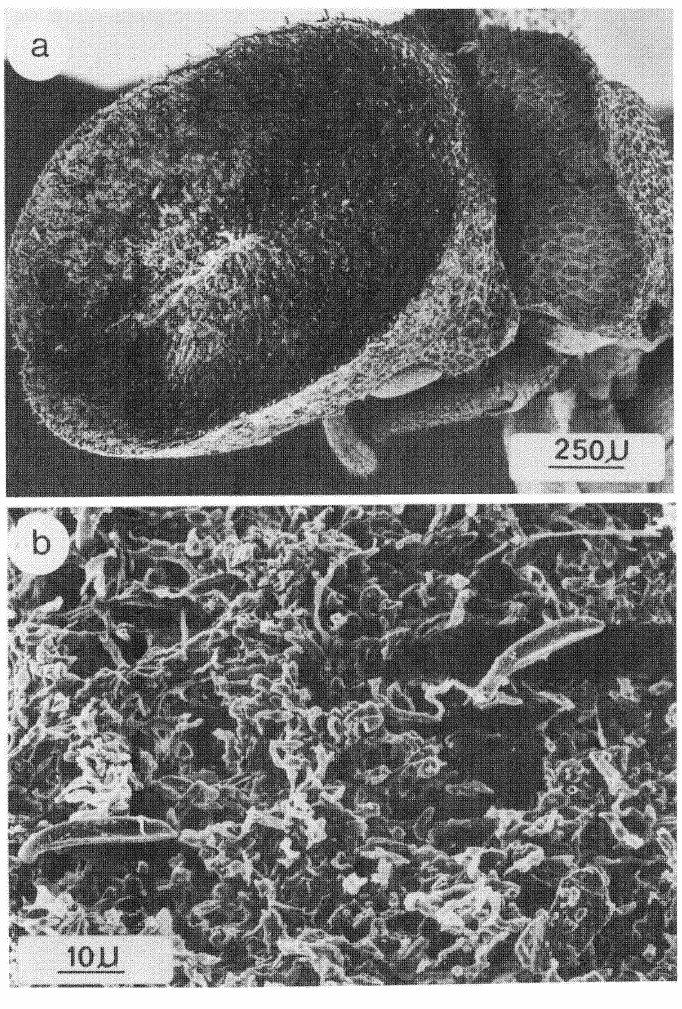
Fig. 4. Zacryptocerus pallens (Kartabo, British Guiana). a. Cephalic shield of soldier. Note central ridge, b. Close up of setae and encrusting